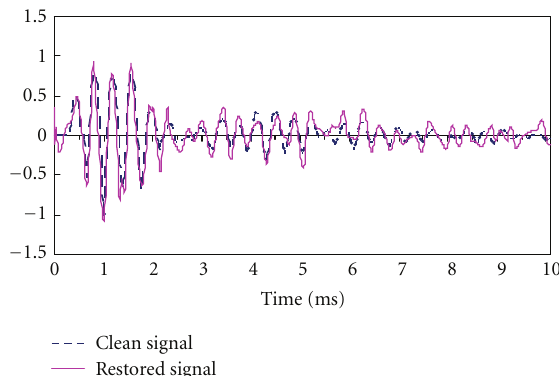
Figure 7: The denoised stress wave signal using proposed